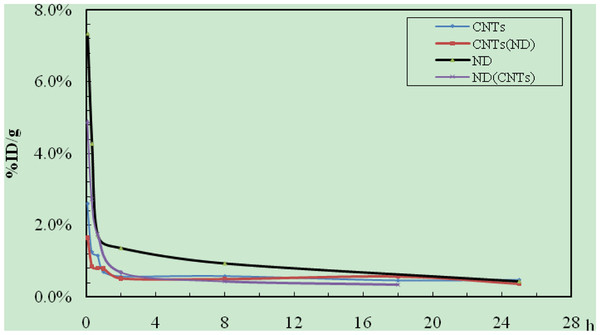
The blood clearance rates from 0 to 28 h. CNTs/99mTc-oMWCNTs; CNTs (NDs)/99mTc-oMWCNTs + NDs; NDs/99mTc-NDs; NDs (CNTs)/99mTc-NDs + oMWCNTs.